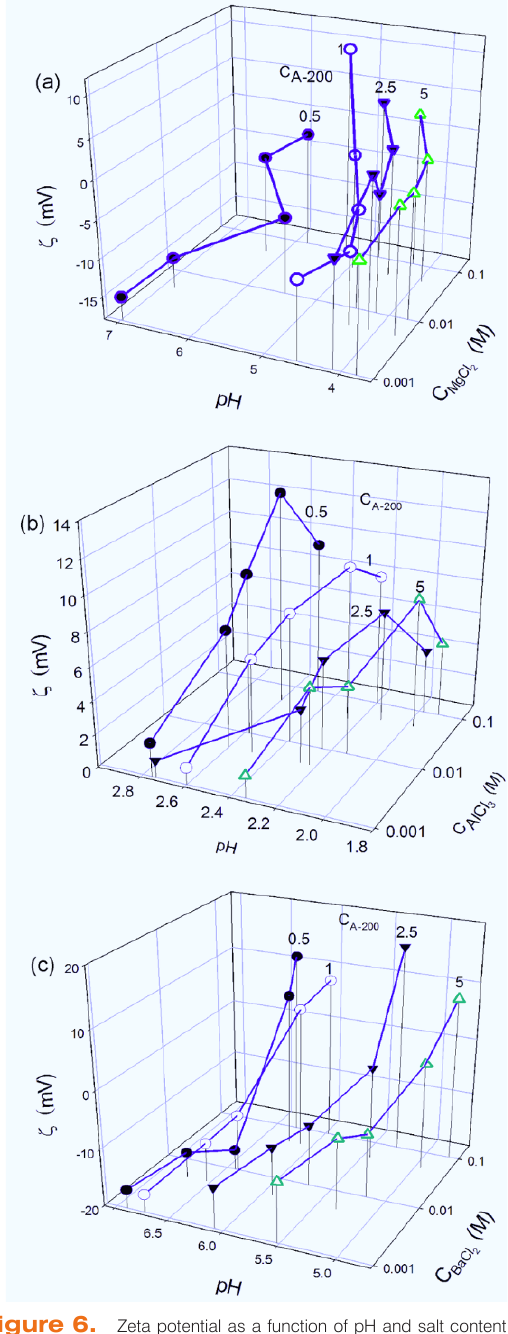
Figure 6. Zeta potential as a function of pH and salt content for (a) MgCl , (b) AlCl , and (c) BaCl at different content of 2 3 2 A-200 in the suspensions: 0.5 ( ), 1 ( ), 2.5 ( ), and 5 ( ) using the Smoluchowski, Ohshima (or Dukhin eq. accounting the surface conductivity) equations can be larger than these calculated for pure silica at pH < 6 [7]. Addition of different salts results in significant changes in the zeta potential of the particles (Figs. 5